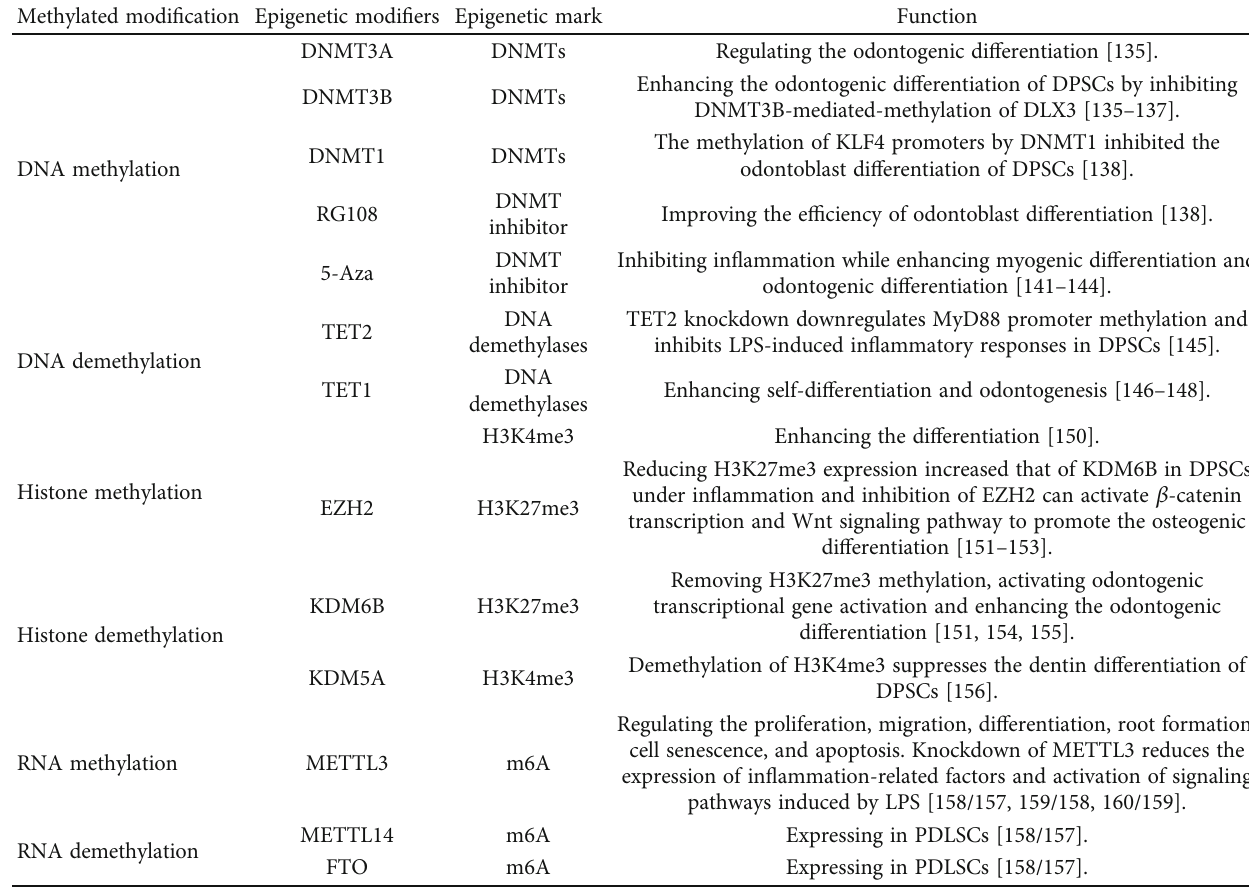
Table 2: Methylation and demethylation in